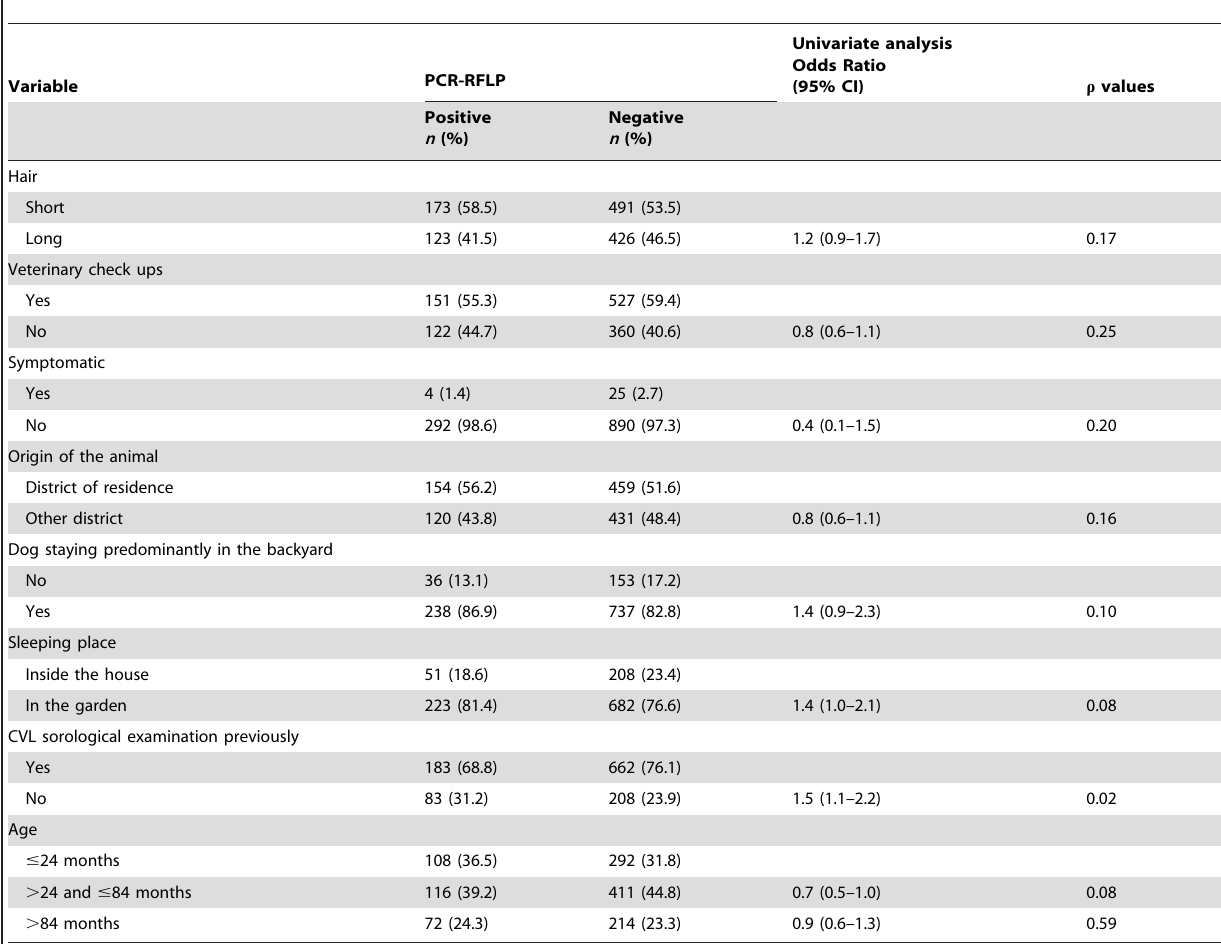
Table 1. Distribution of seronegative dogs ( n =1213) according to the characteristics of the animals, Brazil